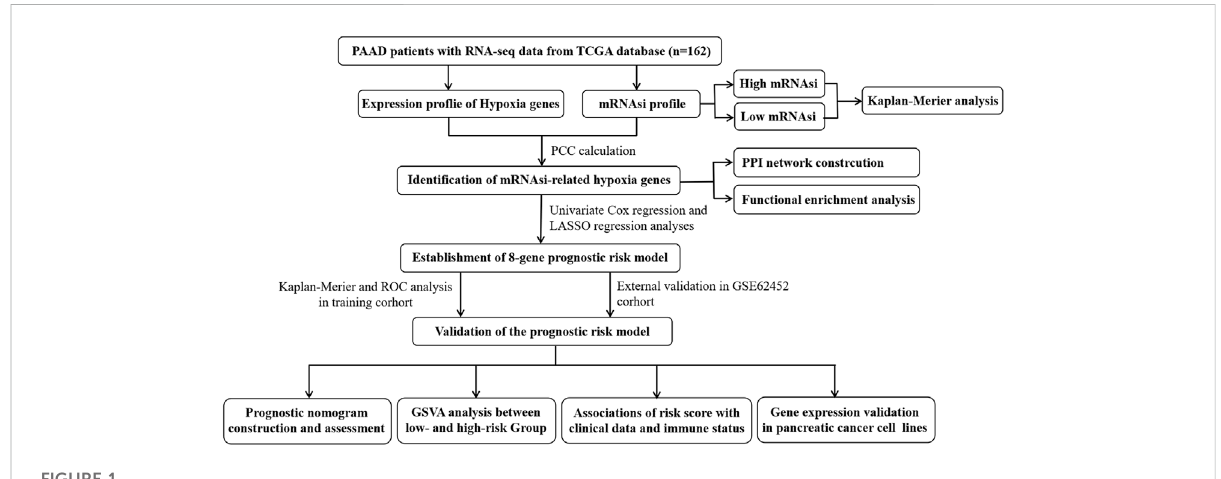
FIGURE 1 Overall fl ow chart of our current work.